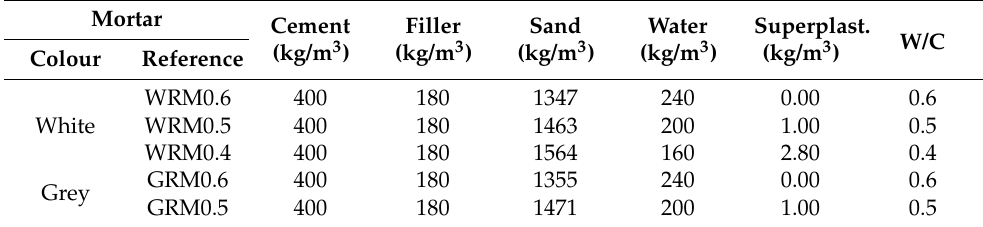
Table 2. Mix Proportions of the restoration reference